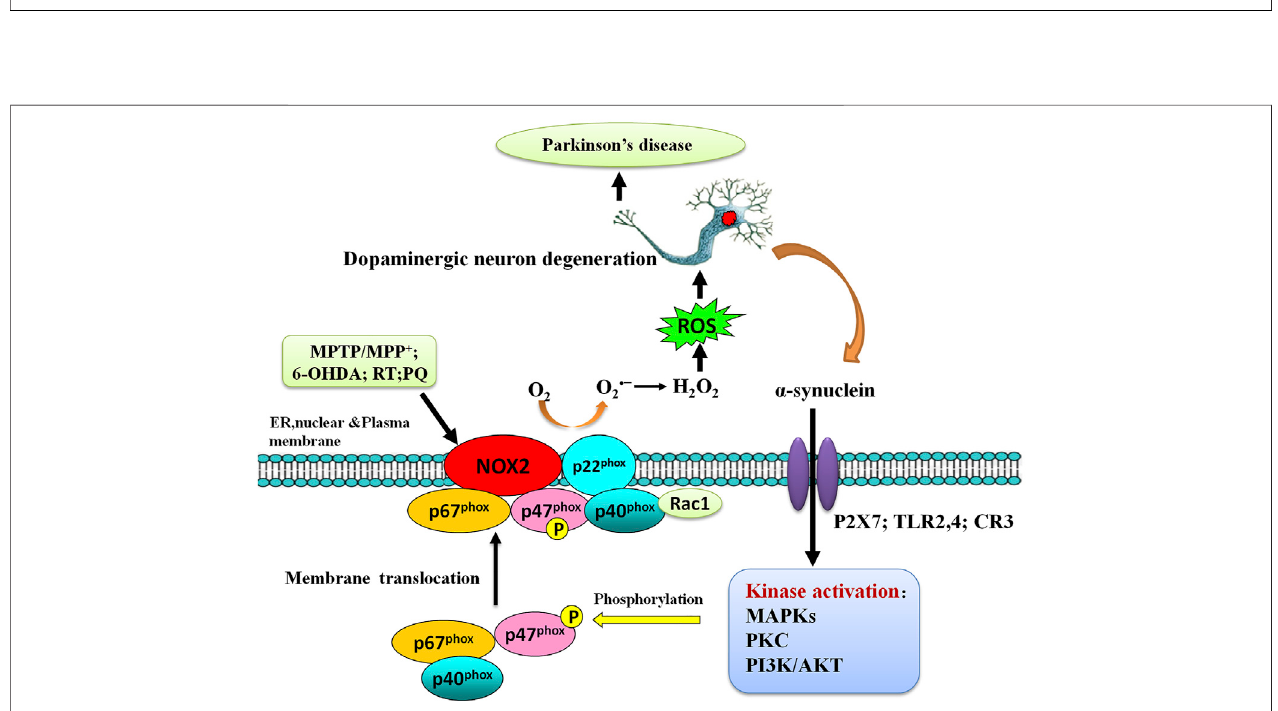
FIGURE 5 | Alpha-synuclein and microglial Nox2 activation. The activation of microglia by alpha-synuclein can implicate several cell-surface receptors, such as P2X7, TLR2/4, and CR3, and subsequent activation of several kinases, such as PKC, Akt, MAPKs, PAK, and ERK1/2. This in turn could promote the phosphorylation and translocation of p47phox and subsequent Nox2 activation. Released oxygen species appear to promote microglia chemoattraction, activation, and OS. Neuronal damage leads to the release of alpha-synuclein and the TLR-agonist high mobility group box protein 1